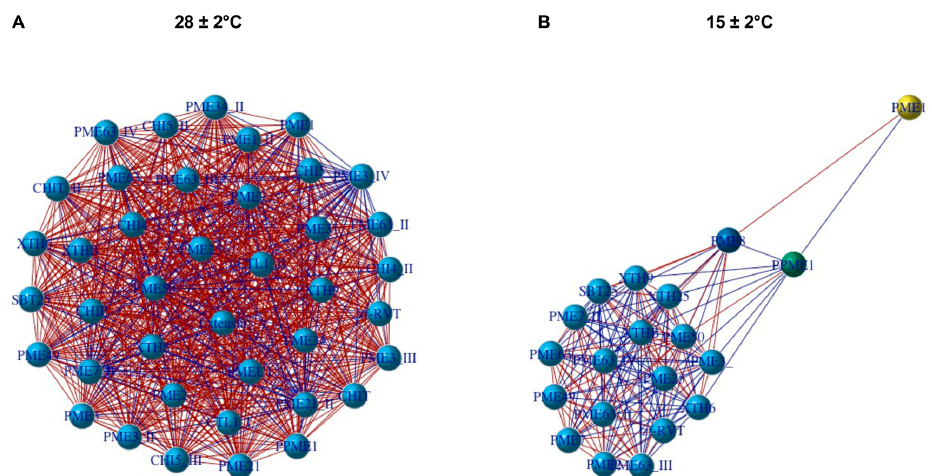
Figure 8. Network analysis of genes related to ripening ( A ) Genes at 28 ± 2 ◦ C and ( B ) Genes at 15 ± 2 ◦ C. Red lines mean high correlation while blue means low correlation.